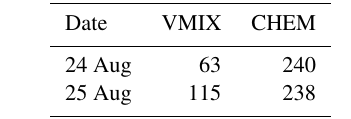
Table 3. Comparisons of the daily totals of the positive contribu- tion (µgm − 3 ) of vertical mixing (VMIX) and chemical reactions (CHEM) to surface O 3 concentrations in the western YRD area from 24 to 25 August 2016.